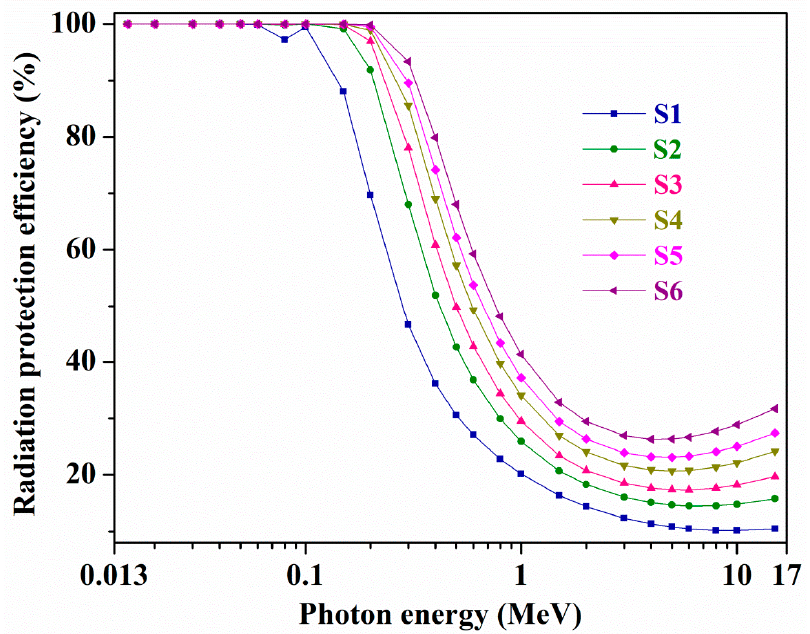
Figure 6. Variations of radiation protection efficiency (RPE) with photon energy (MeV) for all S1–S6 glasses.